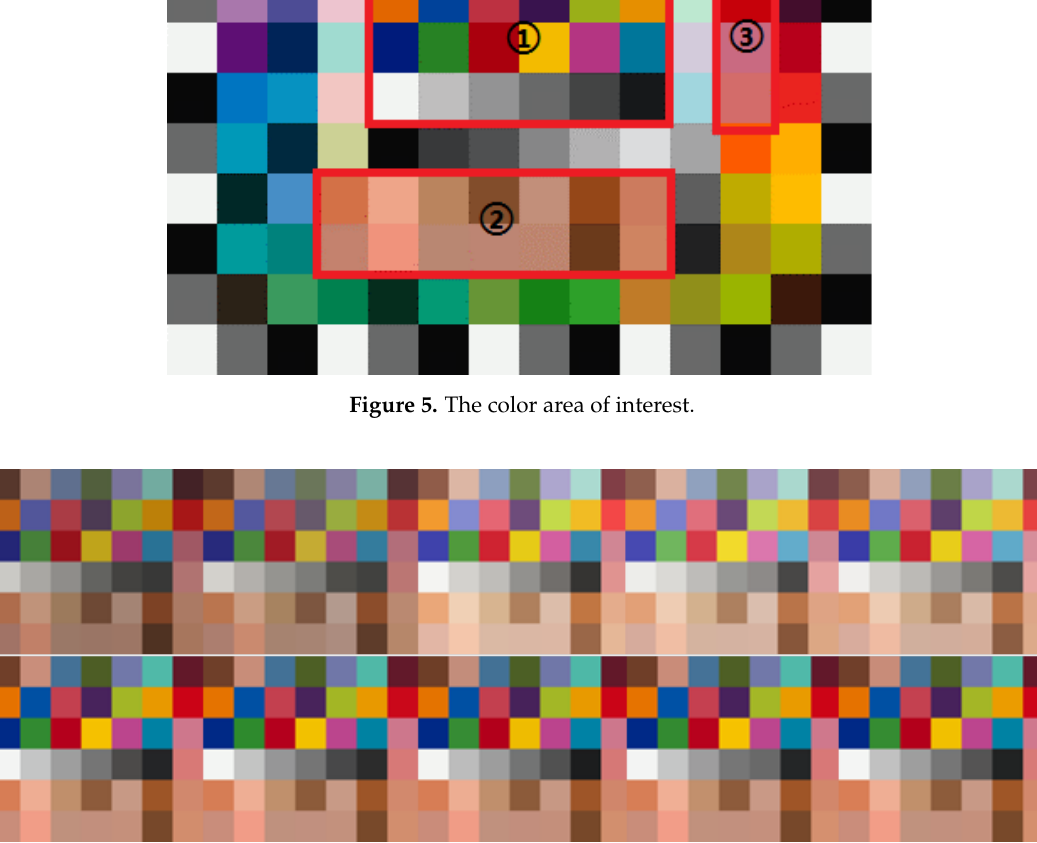
Figure 6. The captured color checkers (upper row) and their corrected results (bottom row) under five different illuminations. From left to right, they are captured under ILL1 to